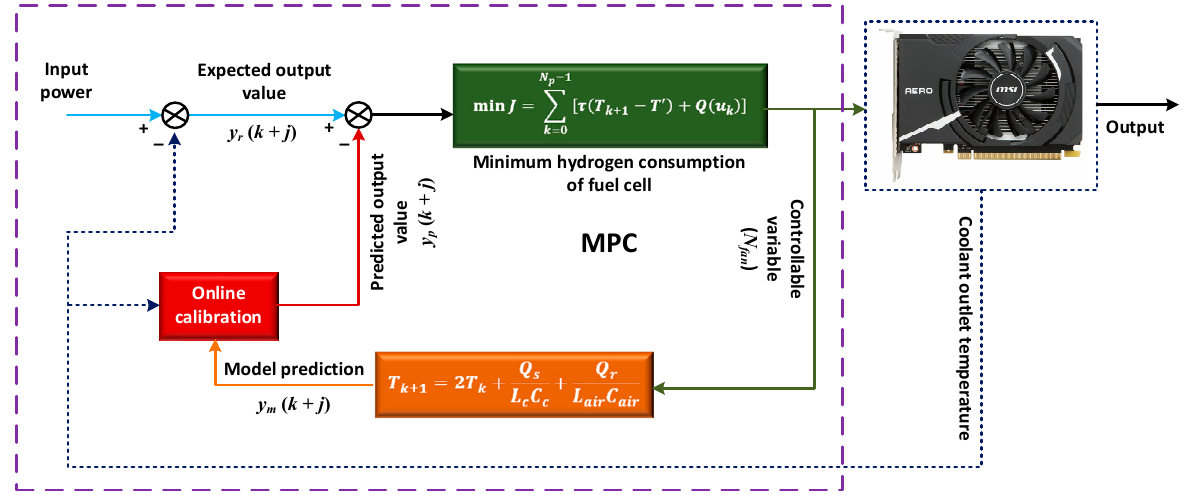
Figure 10. The optimal operating temperature tracking control framework of a fuel cell.